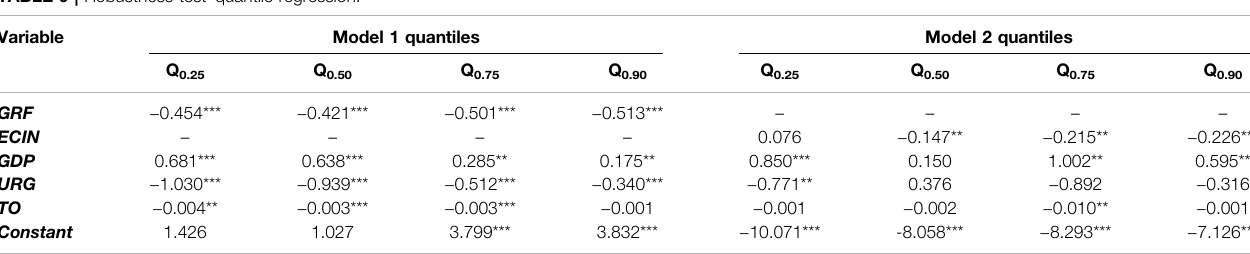
TABLE 9 | Robustness test – quantile